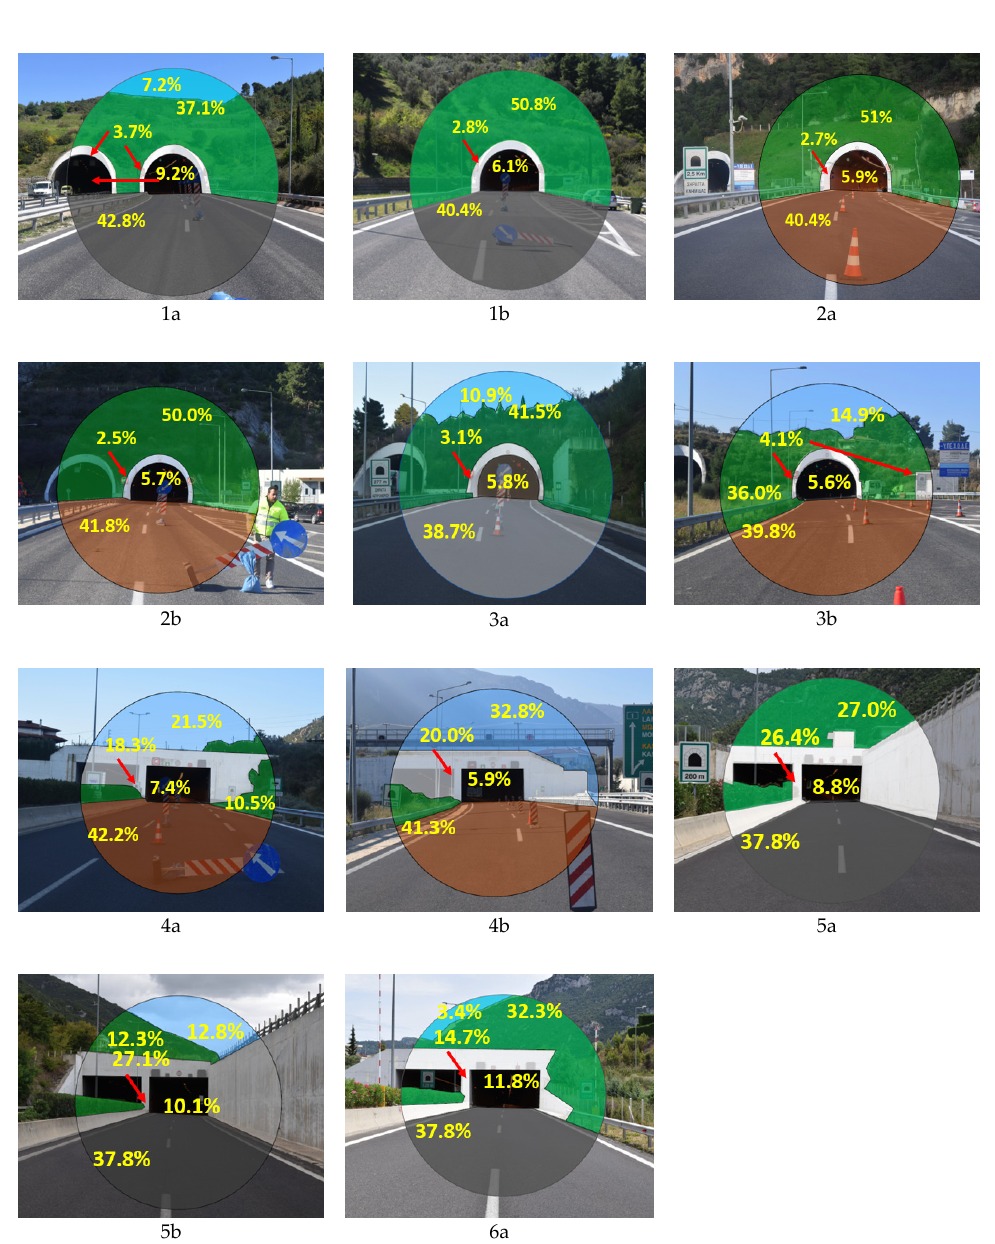
Figure 3. Photographs, taken from a point at a distance equal to the stopping distance from each of the tunnel portals in the middle of the specific motorway, presenting the parts of sky (%), road (%), surroundings (%), and portal (%) used for the calculation of the access luminance L20.